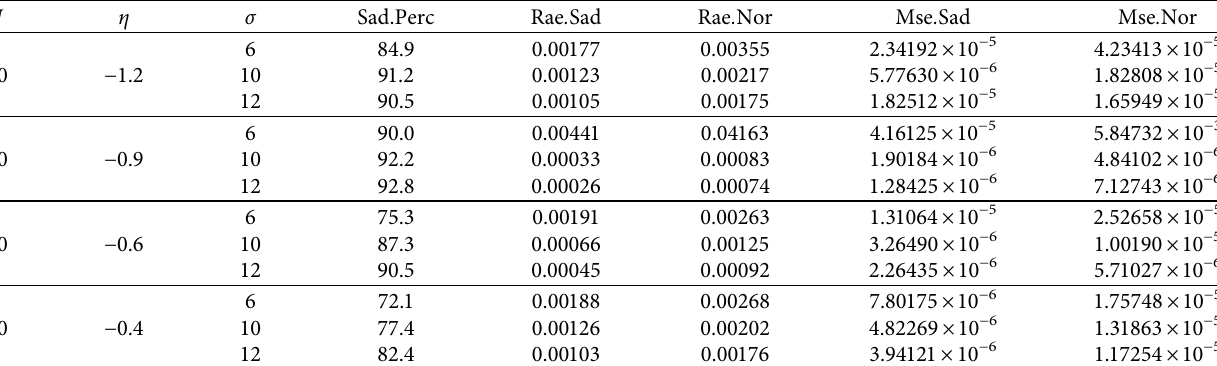
Table 2: Numerical results for the current status